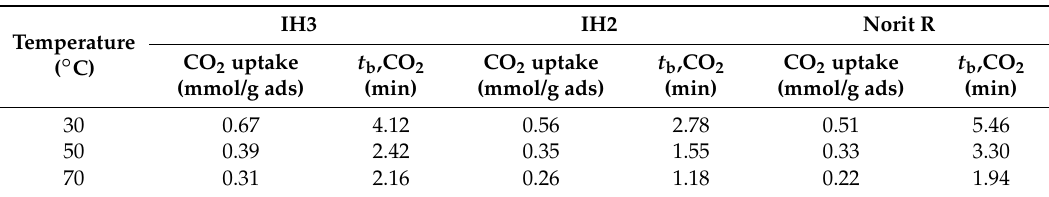
Table 5. CO 2 adsorption capacities and breakthrough times from the experiments at 30, 50 and 70 ◦ C and 140 kPa, feeding binary CO 2 /N 2 gas mixture.